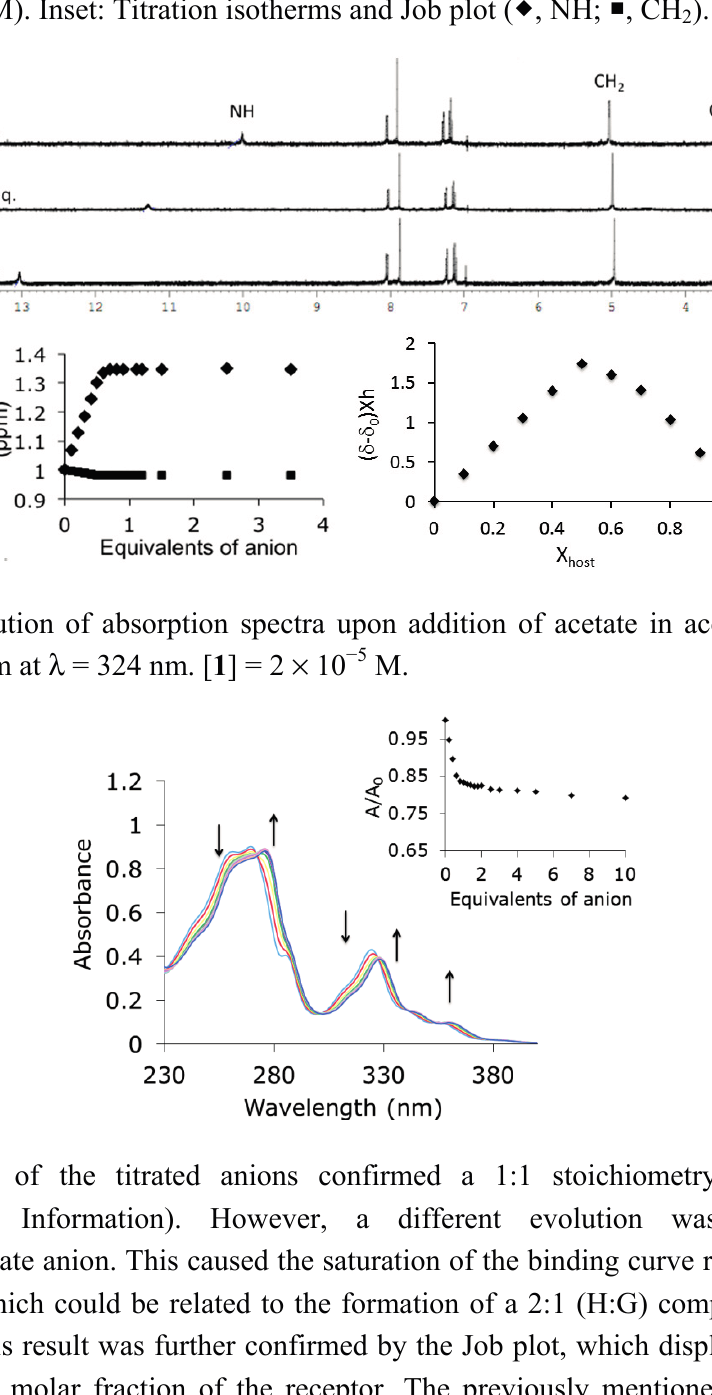
Figure 2. Evolution of 1 H-NMR spectra upon titration of 1 with acetate anions in CD